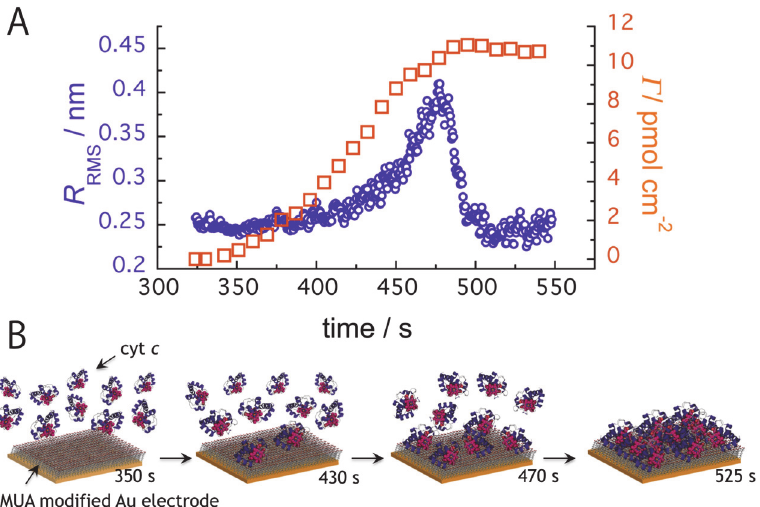
Figure 3. Time-course analysis of R RMS and Γ values. (A) Time evolution of R RMS values from the HS- AFM images (open circle) and the level of electrochemically active cyt c ( Γ ) from the cyclic voltammograms (open square). (B) Schematic of the adsorbing cyt c molecules on the MUA-modified electrode at each time